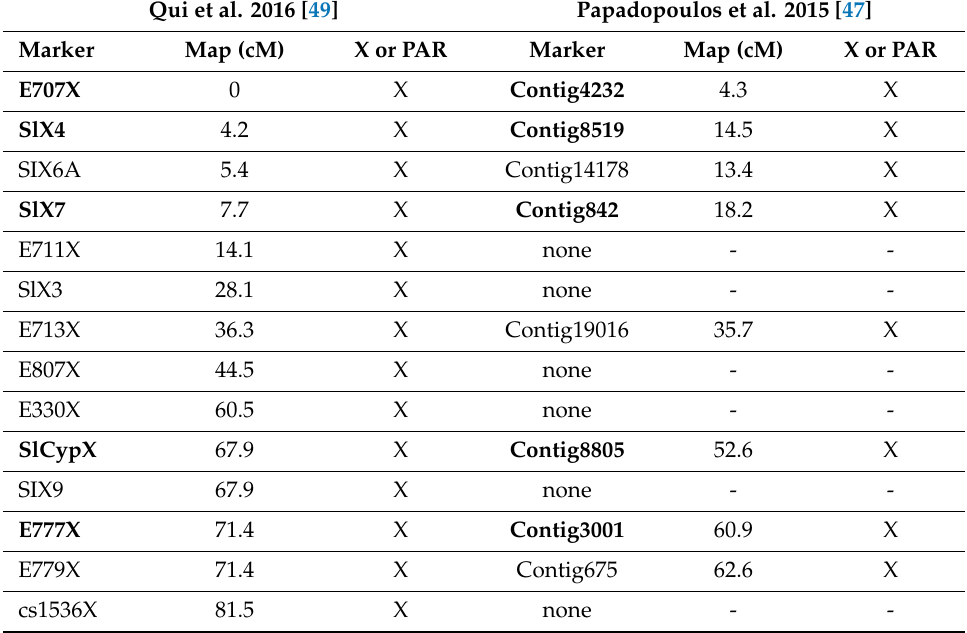
Table 2. The markers in common between di ff erent studies of the pseudoautosomal region (PAR) and the X chromosome. The markers in bold are the same genes in both maps; the other markers (not in bold) co-locate on genomic sca ff olds, but they are not the same